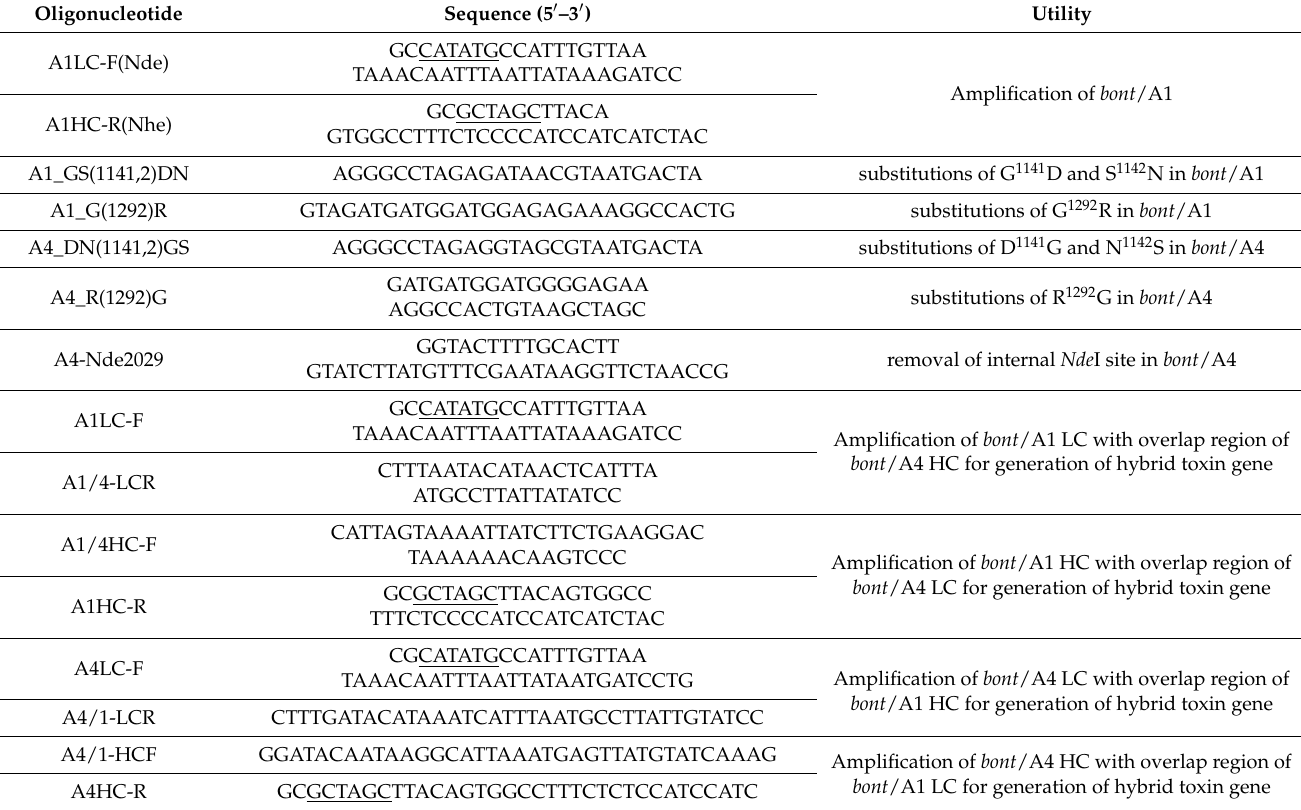
Table 3. List of oligonucleotide primers used in this